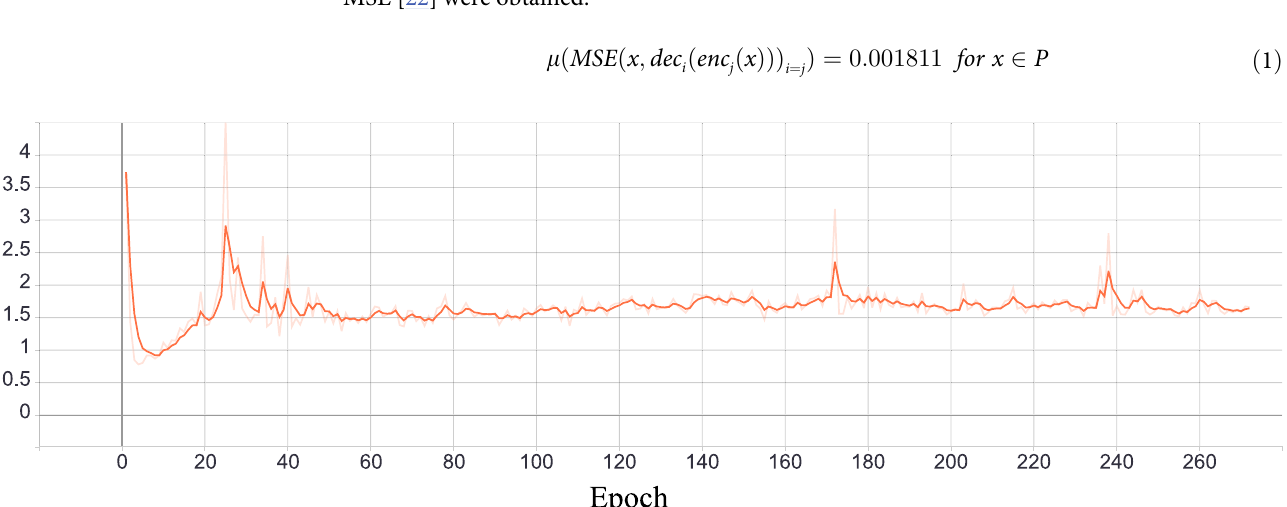
PLOS ONE | https://doi.org/10.1371/journal.pone.0254181 July 6,